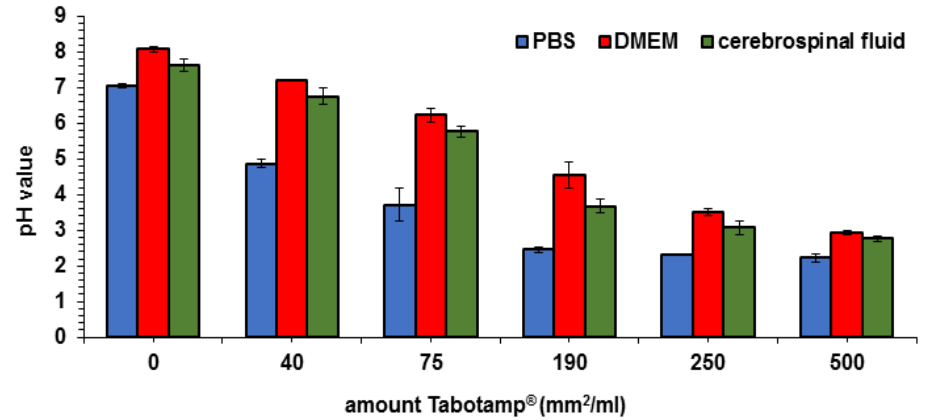
Figure 1. Impact of Tabotamp ® load and media composition on pH values determined with pH electrode. The diagram shows the means and standard deviations of three independent experiments.